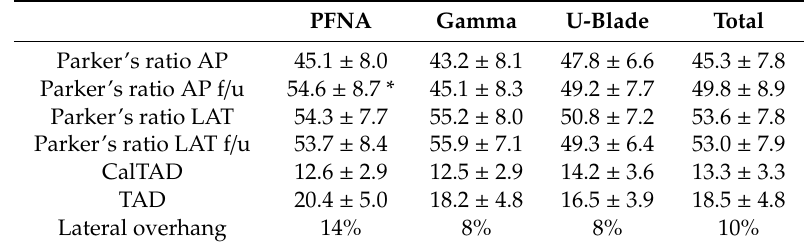
Table 2. Lag screw / blade position in the femoral head and neck fragment post-implantation and at latest